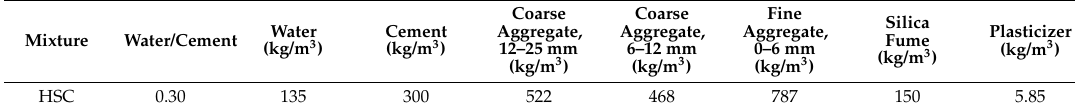
Figure 1. Mixture design.